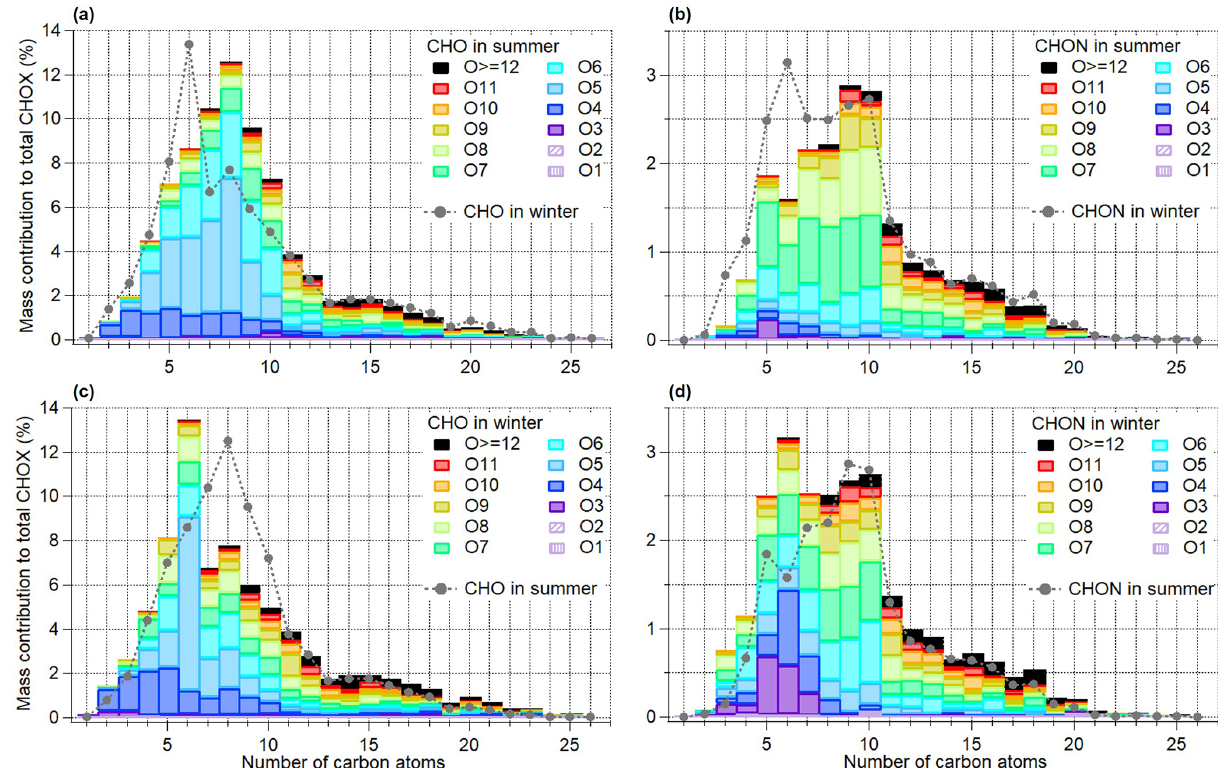
Figure 2. Mass contribution of CHO and CHON compounds with different numbers of oxygen atoms as a function of the number of carbon atoms to total CHOX compounds for the summer (a, b) and winter (c, d) periods. The corresponding distribution for the other season is plotted as a gray dotted